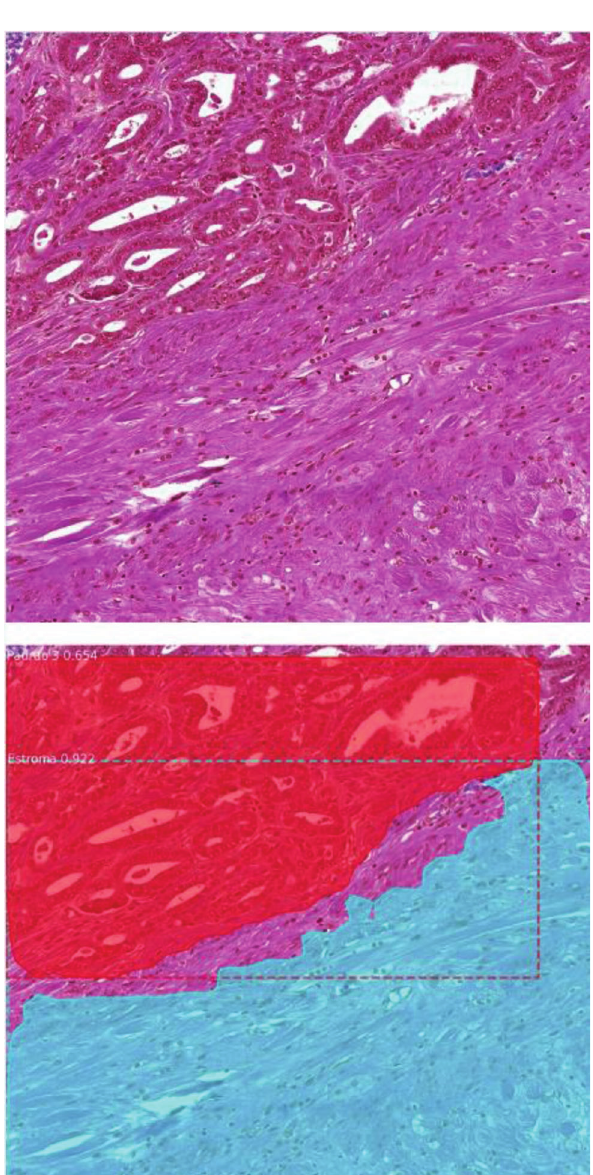
Figure 1 - Scanning method example—The upper image shows an image patch extracted from a radical prostatectomy specimen slide. The lower image demonstrates the scanning model prediction. The method automatically detected a Gleason 3 pattern area in the upper part of the image and stroma tissue in the lower part of the